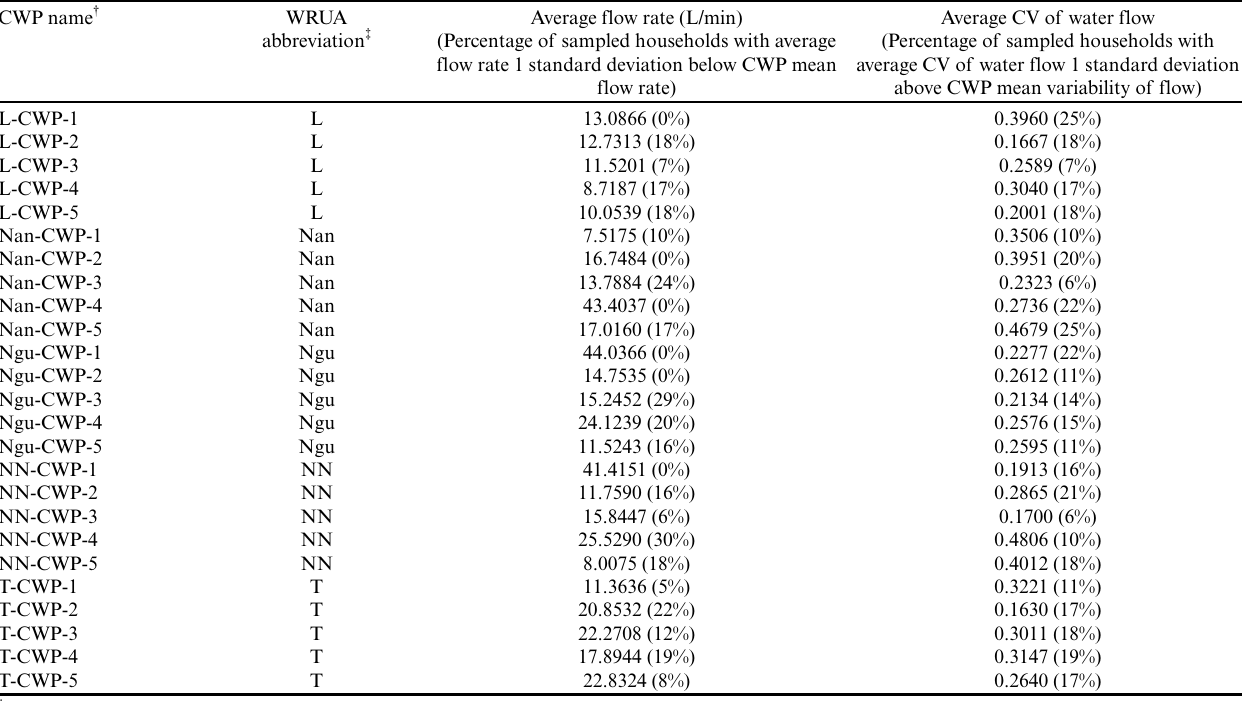
Table 6. CWP water